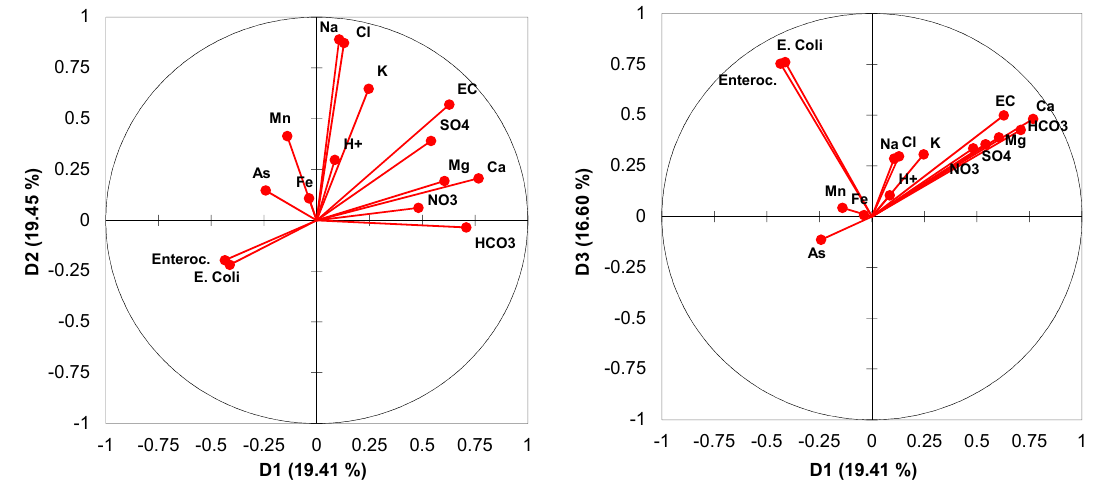
Figure 4. Distribution of the parameters on the PCs D 1 , D 2 and D 3 , after orthomax rotation.